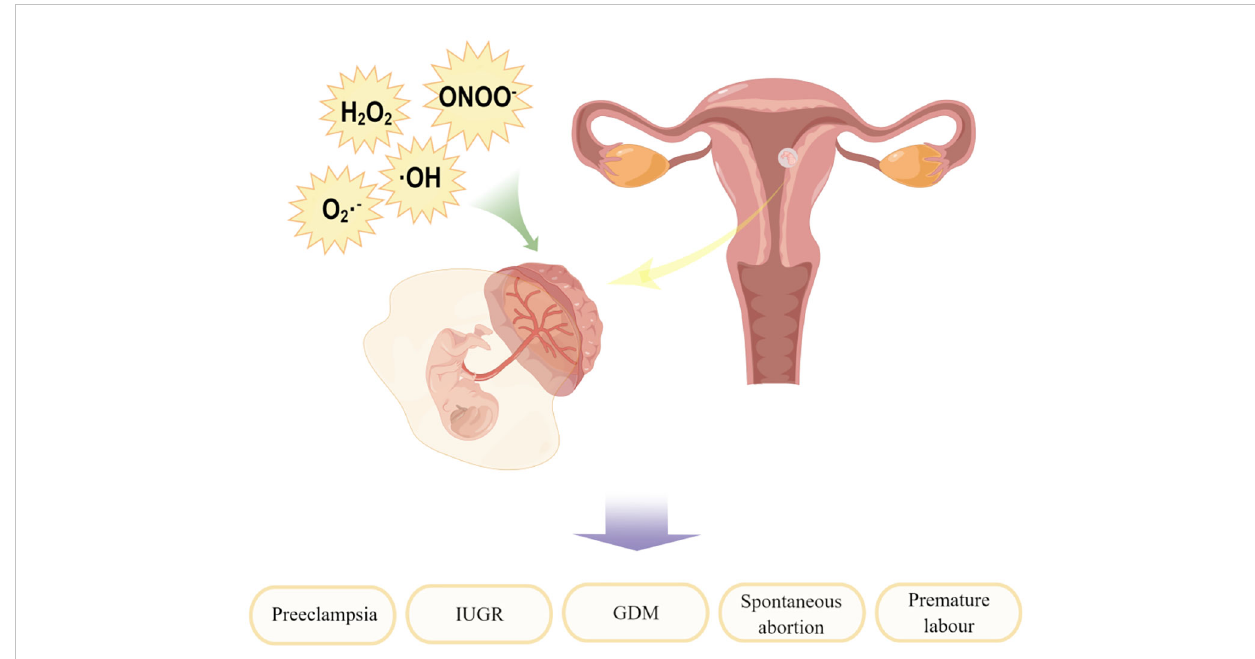
FIGURE 2 Factors contributing to the development of oxidative stress and their impact on maternal-fetal interface. By